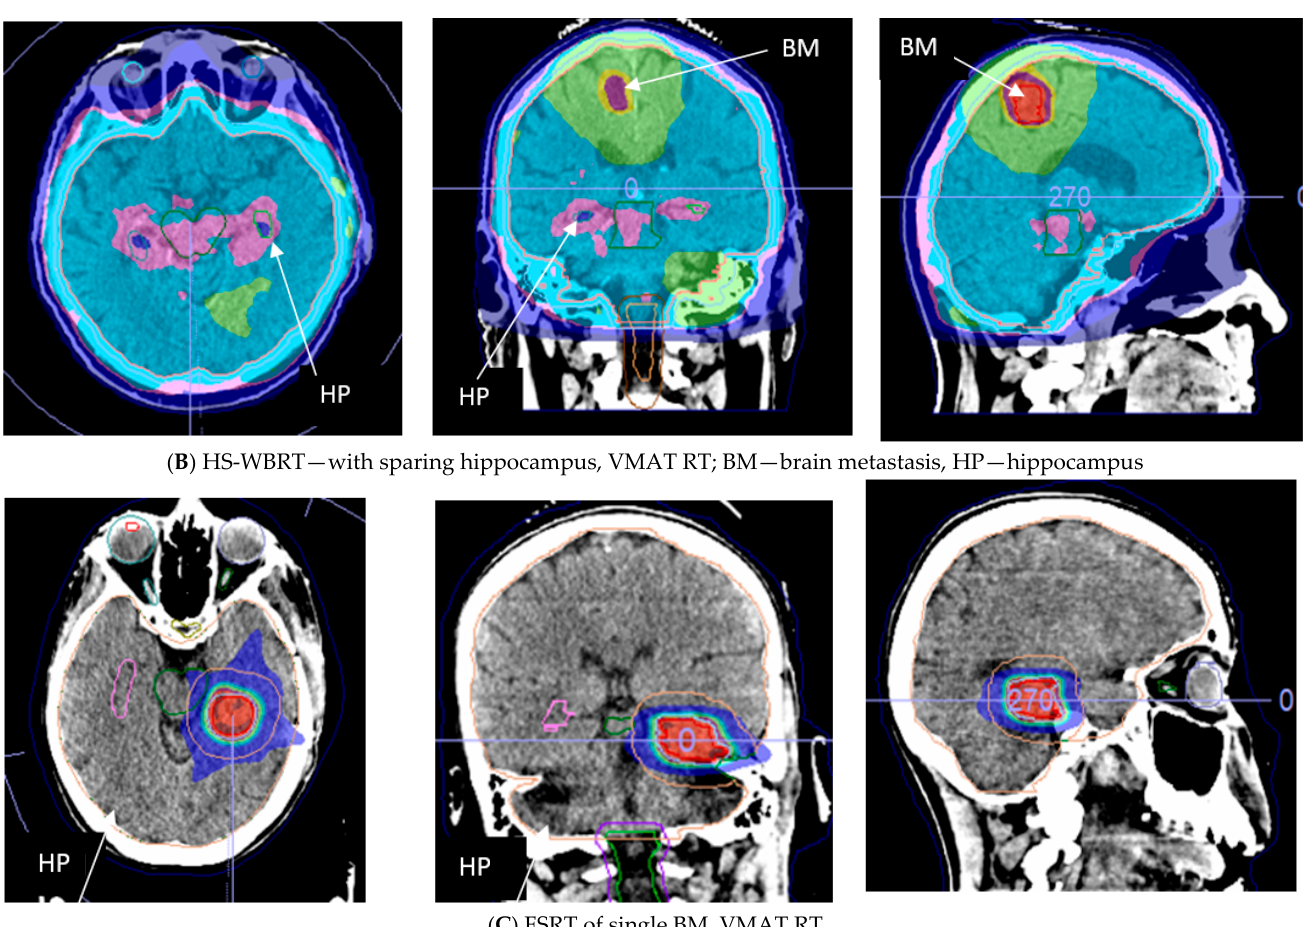
Figure 2. Brain radiotherapy in patient with brain metastasis without hippocampus sparing ( A ), with sparing hippocampus by HS-WBRT ( B ) or FSRT ( C ); Abbreviations: RT—radiotherapy, WBRT—whole brain radiotherapy, VMAT—volumetric arc therapy, HS-WBRT—hippocampal sparing whole brain radiotherapy, FSRT—fractionated stereotactic radiotherapy.